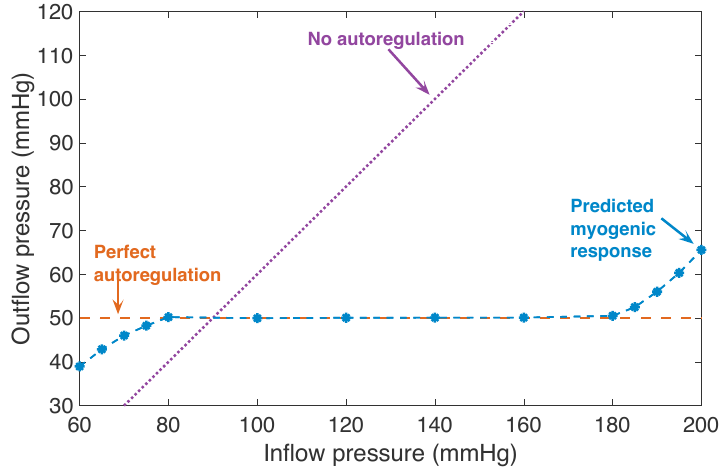
Figure 5. Predicted myogenic response ( blue ) compared to perfect autoregulation ( red ) and no autoregulation ( purple ) of blood flow through the vessel for a range of blood pressures. For illustrative purposes, we show a straight line for the case of no autoregulation that qualitatively captures the response under this assumption (actual slope may